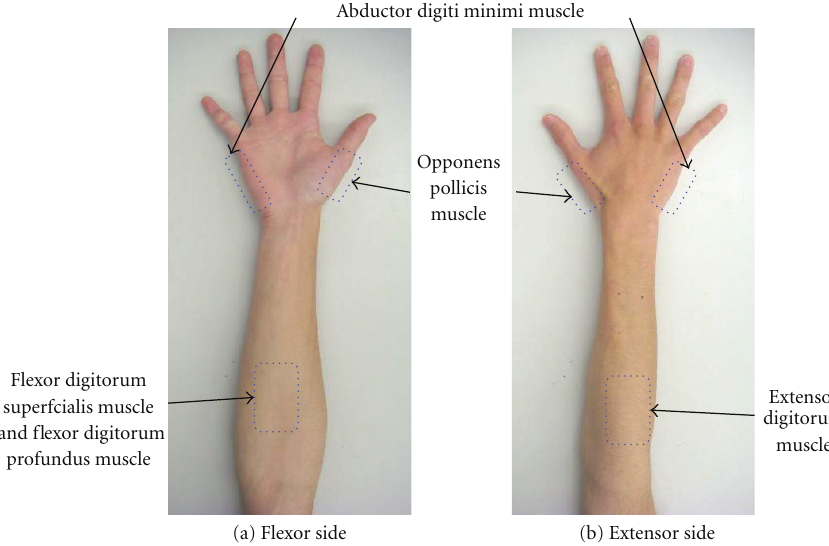
Figure 3: The muscles related to finger motion. The muscle functions are as follows: the flexor digitorum superficialis muscle is for PIP joint flexion of the 2–5th fingers and is innervated by the median nerve. The flexor digitorum profundus muscle is for DIP joint flexion of the 2-5th fingers and is innervated by median nerve. The extensor digitorum muscle is for MP, PIP, and DIP extension of the 2–5th fingers and is innervated by the radial nerve. The above 3 muscles are located at the forearm. The abductor digiti minimi muscle is for abduction of the pinkie and is innervated by the ulnar nerve. The opponens pollicis muscle is for thumb opposition motion and is innervated by the median nerve. These two muscles are in the